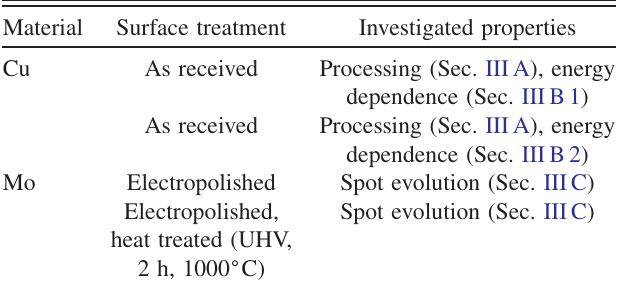
TABLE I. Samples and surface treatments investigated. Material